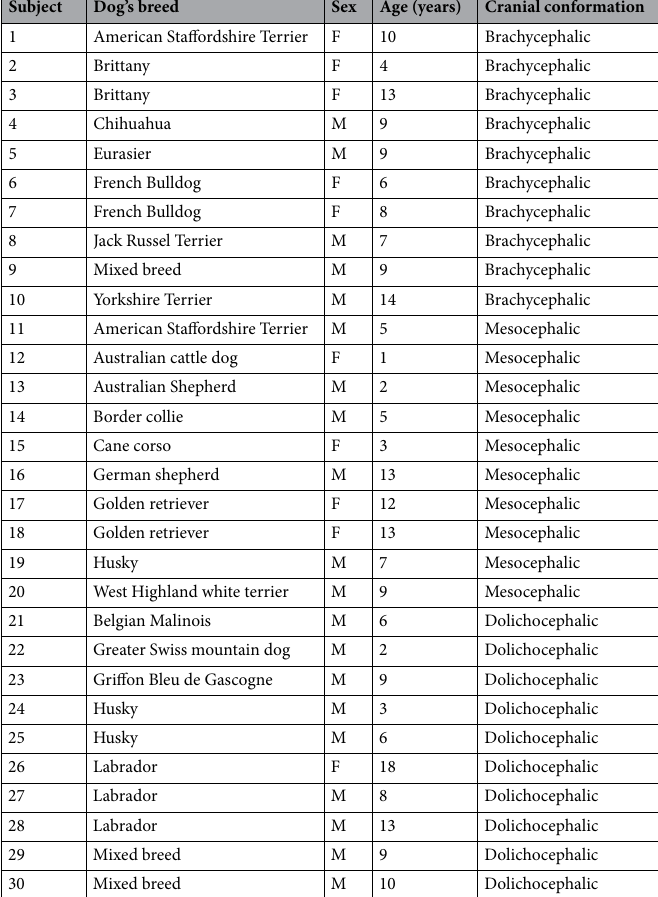
Table 1. Dogs study population by race, sex (F: Female, M: Male), age and cranial